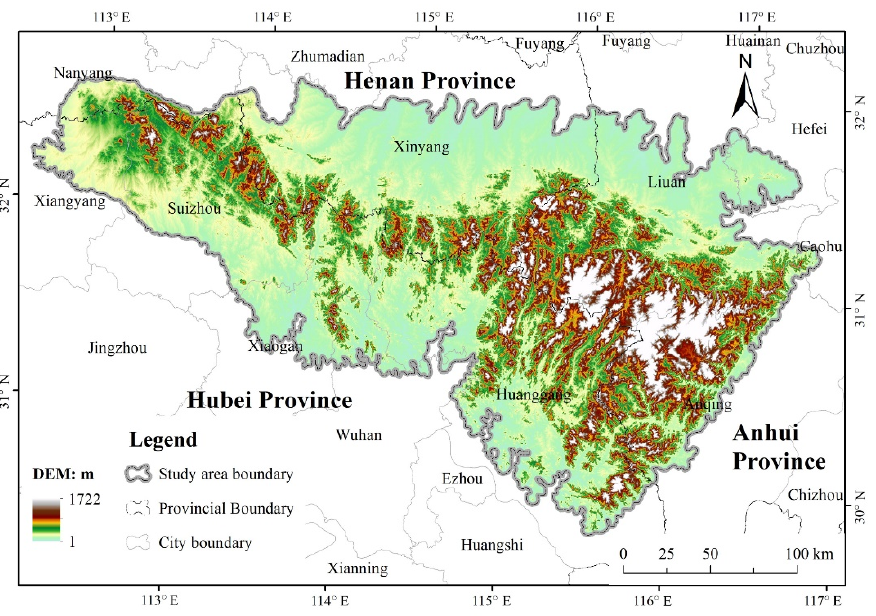
Figure 1. The location of the study area is at the junction of Henan, Hubei, and Anhui Provinces.